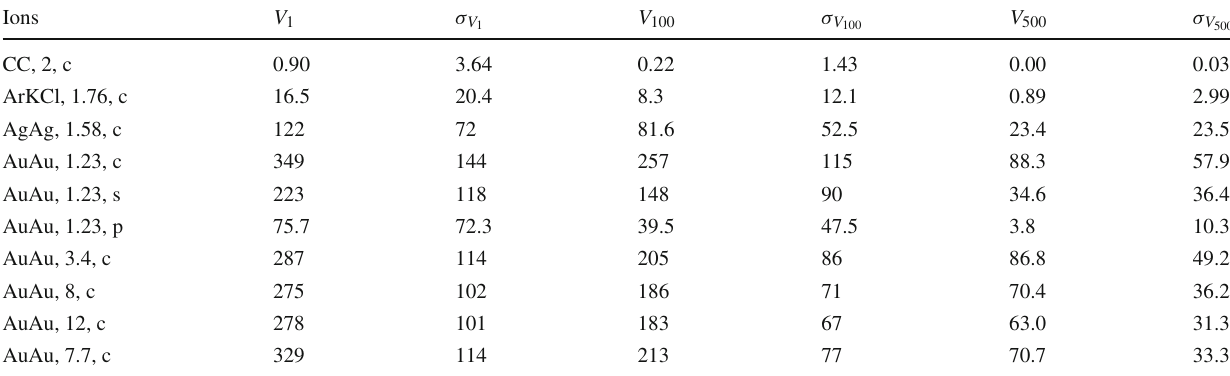
Table 8 Results for X ebe < 0 . 3 and Y ebe < 0 . 3